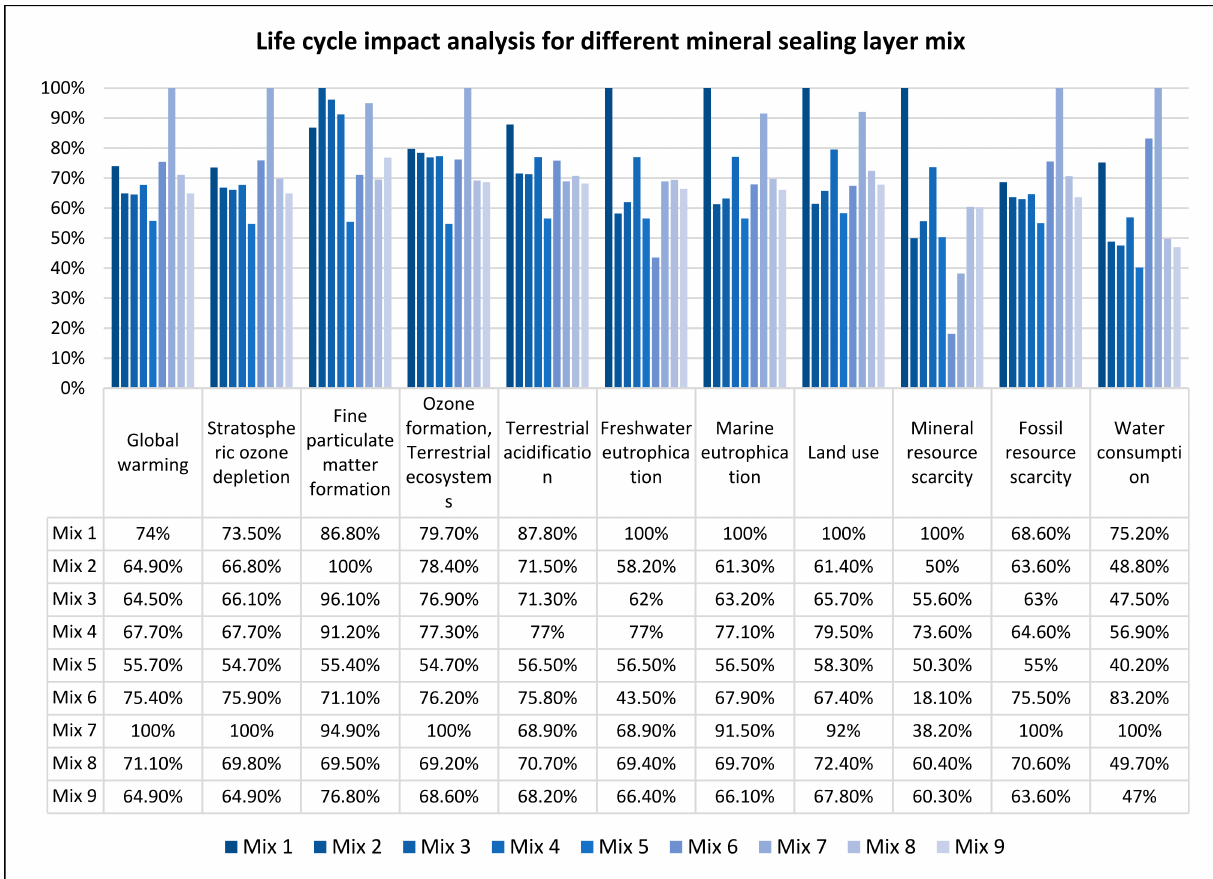
Figure 9. Life cycle impact analysis for different mineral sealing layer mix.